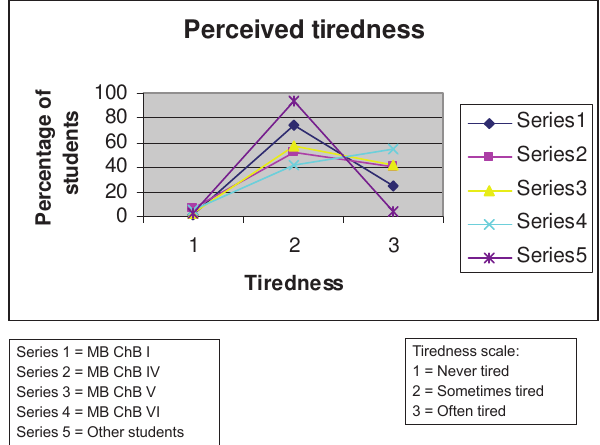
Fig. 1. Tiredness as reported by students.